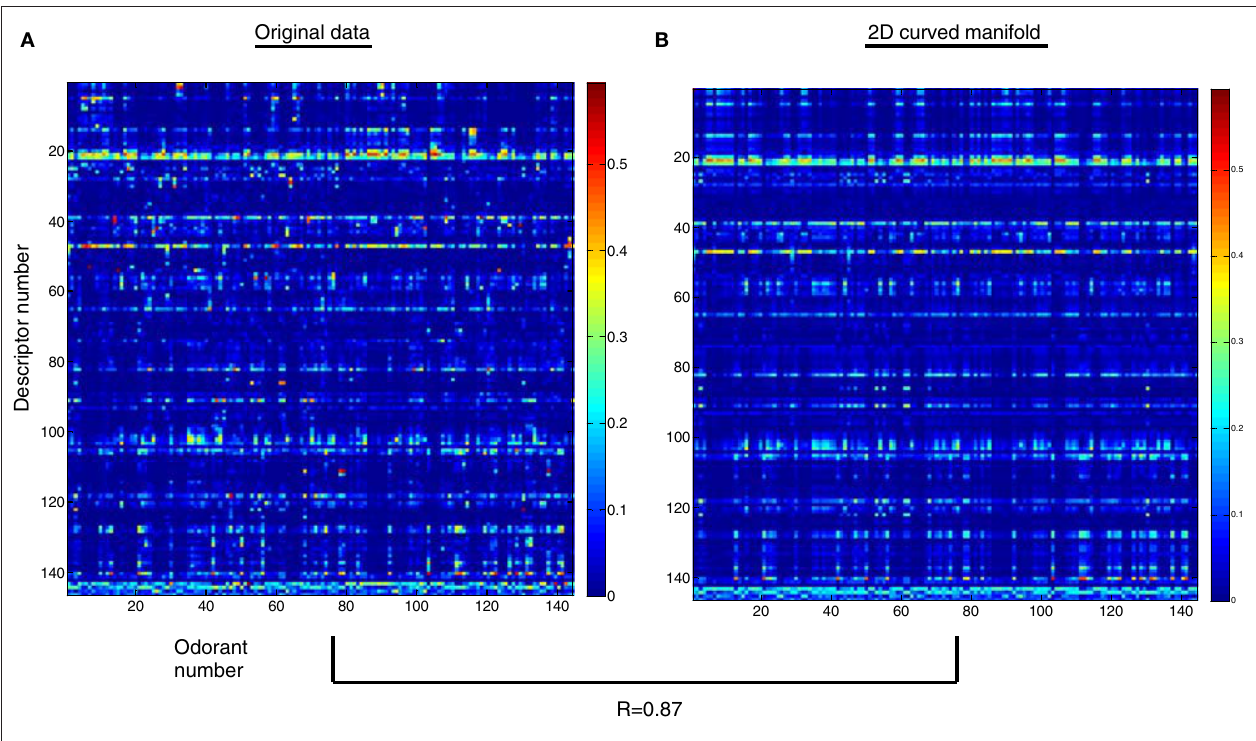
Figure 2 | Comparison between original perceptual data and its their projection on to a 2D curved manifold. Images represent the coordinates (color coded) of 144 odorants in 146D space of descriptors for (A) the original data, (blue crosses in Figure 1 C,D ) and (B) their projections onto a 2D curved manifold (circles in Figure 1